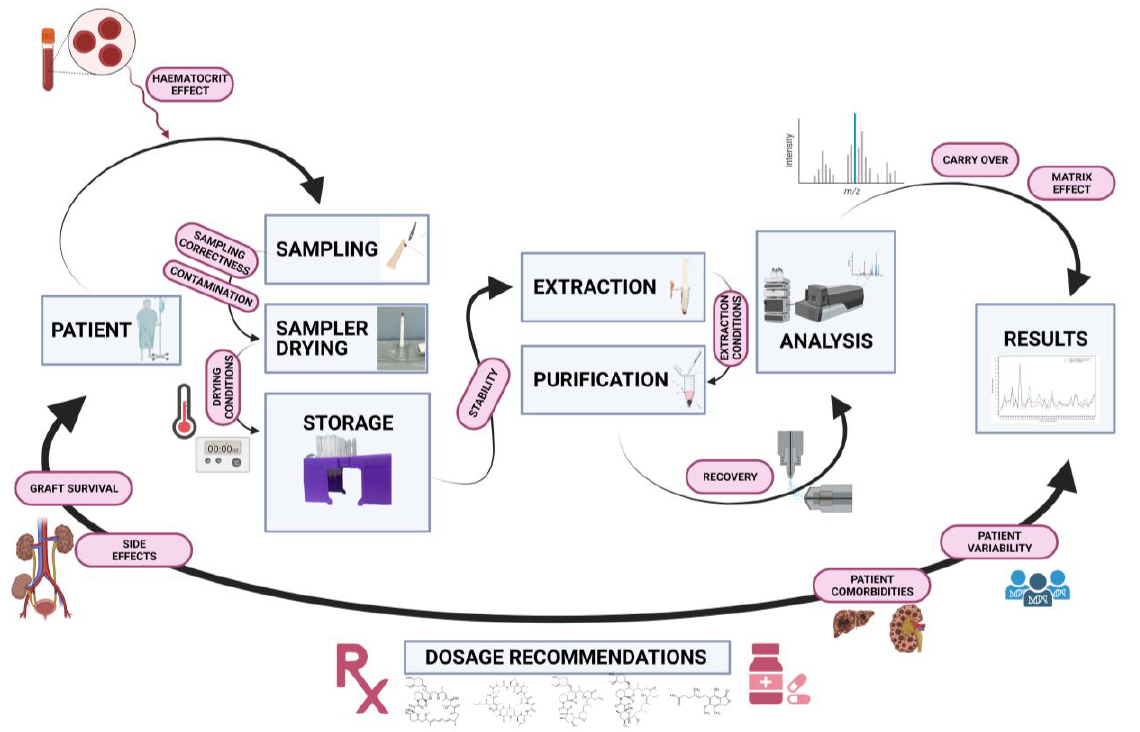
Figure 1. Preanalytical, analytical, and clinical process summary with the main critical points. Created with BioRender.com under publishing rights.